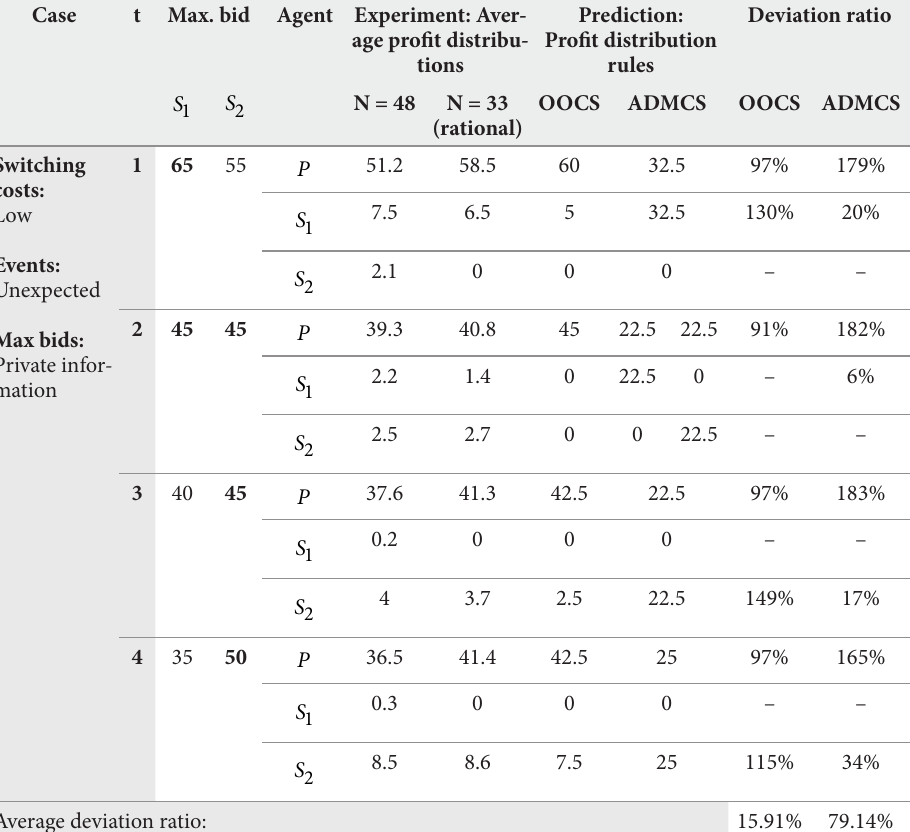
Average deviation ratio: